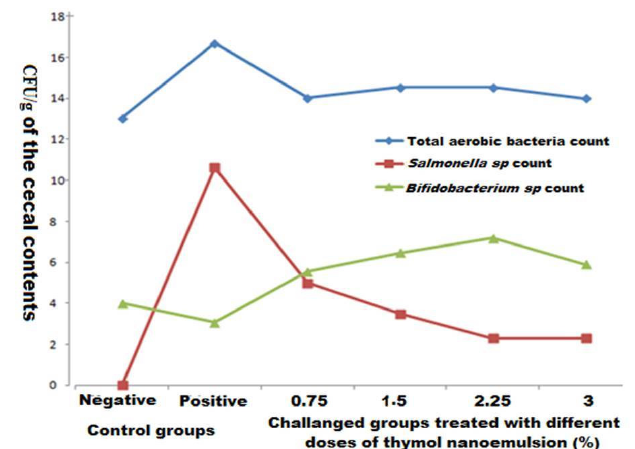
Figure 3. Bacterial counts in cecal contents of S. Enteritidis challenged broilers as affected by treat- ment with 0.75, 1.5, 2.25, and 3% thymol